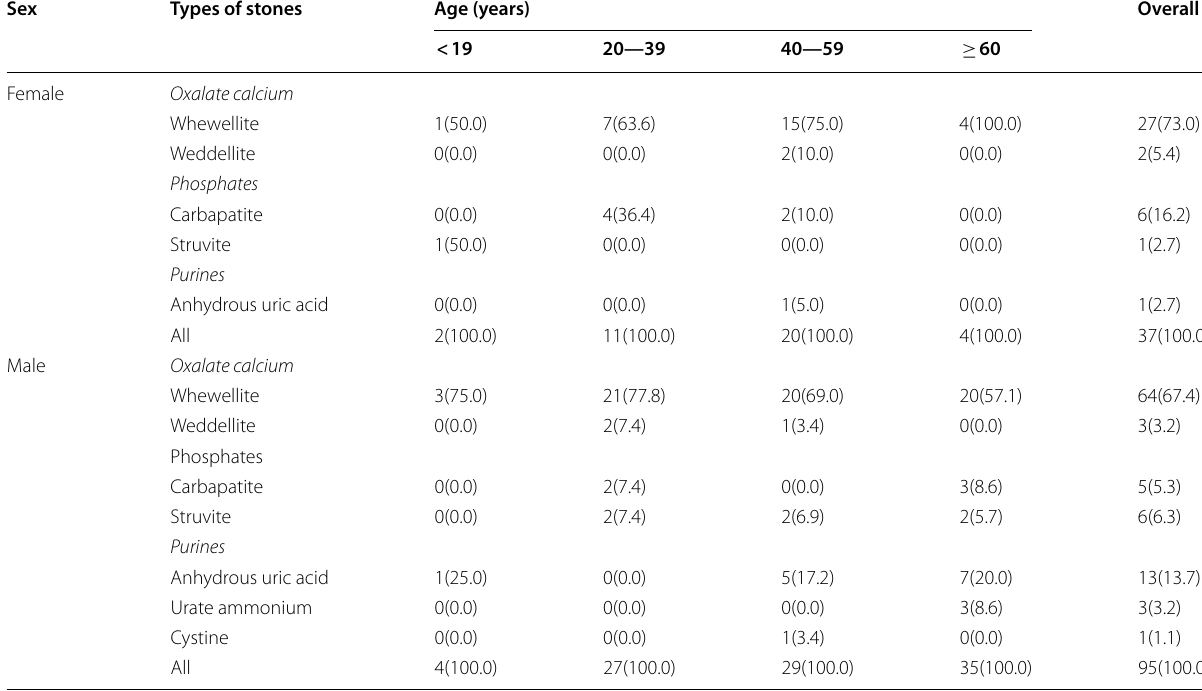
Table 6 Distribution of main types of stones according to age groups and gender Sex Types of stones